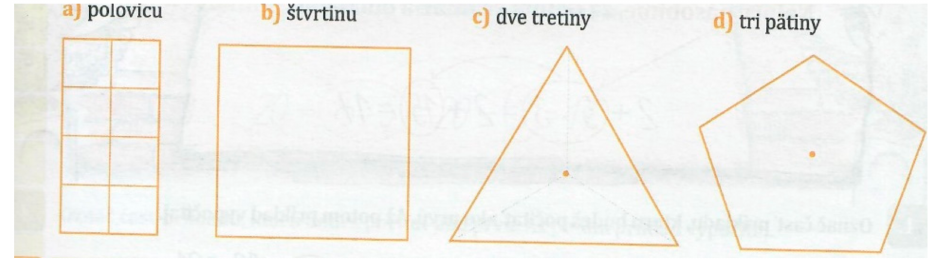
Figure 2. Task: Color in ( a ) half, ( b ) quarter, ( c ) two-thirds, ( d ) three-fifths